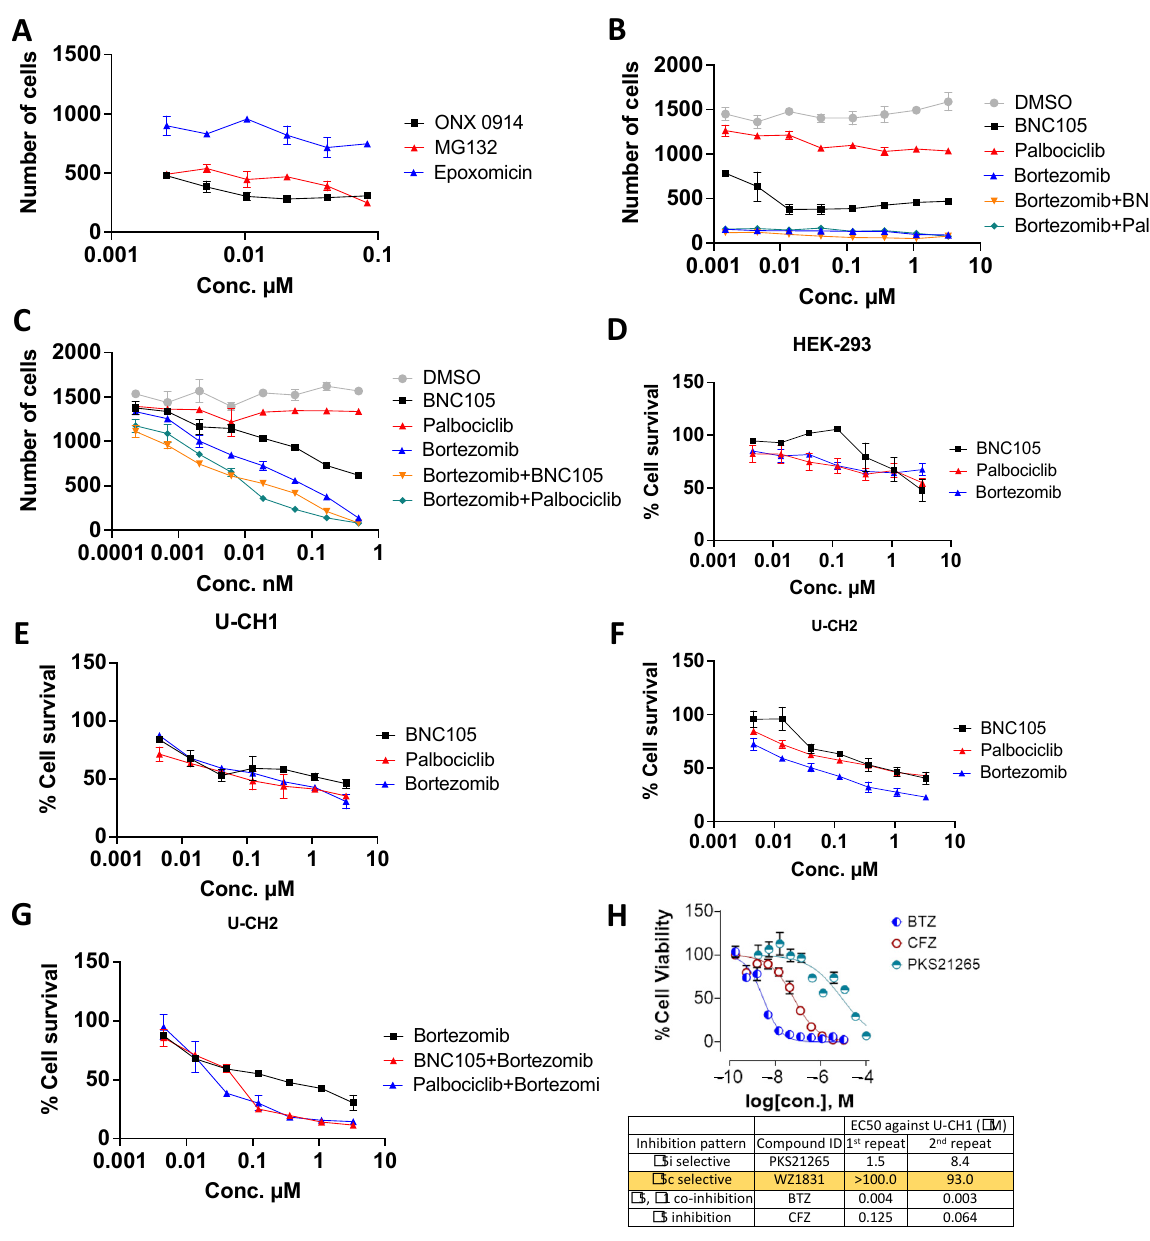
Figure 4. Primary assays identify proteasomal inhibitors as a specific therapeutic agent, alone or in combination with other anti-cancer drugs . ( A – C ) Nuclear count. ( A ) Dose dependency curves for three proteasomal inhibitors showing reconfirmation of these three inhibitors. ( B ) High-dose and ( C ) Low-dose dependency curves for Bortezomib and BNC105 or Palbociclib alone or in combination, showing low-dose synergistic cell-killing activity of chordoma cells. Dose dependency study using proliferation assays ( D ) HEK-293 cells, ( E ) U-CH1 and ( F ) U-CH2 cells alone or ( G ) in combination. ( H ) Percentage cell survival evaluated for BTZ, CFZ, and PKS21265 and the IC 50 values for β 5i- and β 5c-selective and co-inhibition in U-CH1 cells. Proteasomal subunits PSMB5 and PSMB8 are highly upregulated in chordoma cell lines U-CH1 and U-CH2: As we found, proteasomal inhibitors as one class of the hits from primary screening; next, we asked whether proteasomal subunits are increased in chordoma. We performed the gene expression analysis of proteasomal subunits PSMB5 and PSMB8 by qRT-PCR in U-CH1 and U-CH2 cells, as compared to non-cancerous cell lines HEK- 293 and HUVEC. Our data show a significant increased expression for both PSMB5